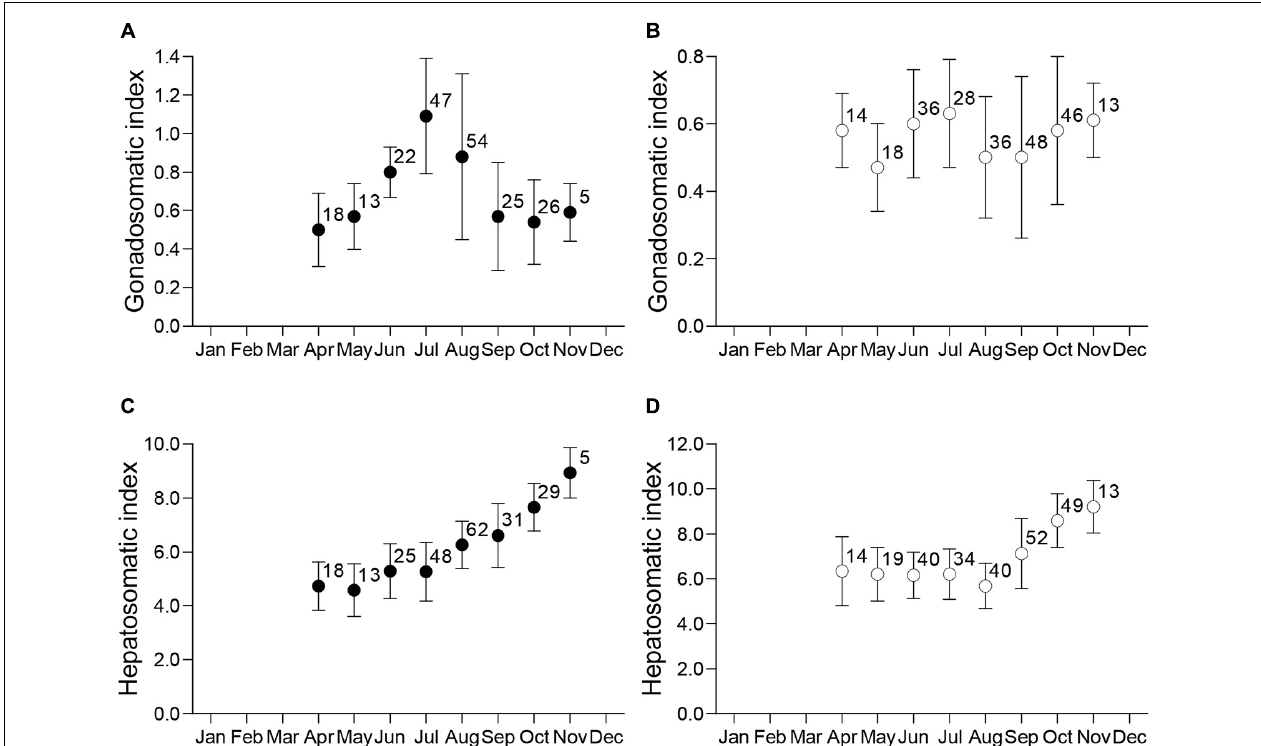
FIGURE 3 | Monthly distributions of the mean ± standard deviation and sample size for the gonadosomatic index ( I G ) for mature males (A) and females (B) , and hepatosomatic index ( I H ) for mature males (C) and females (D)